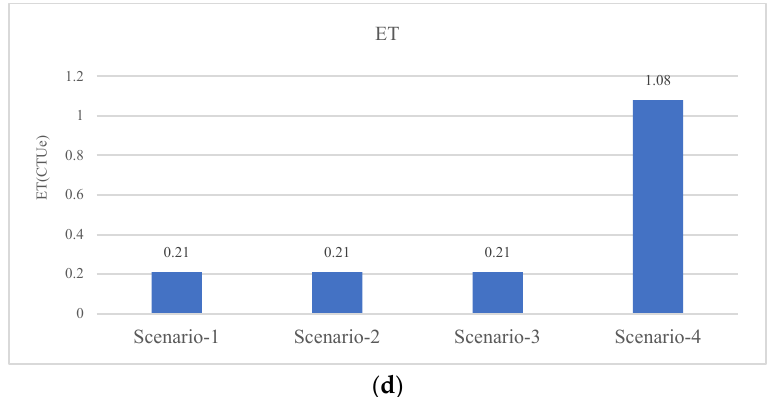
Figure 8. Results of impact assessment. ( a ) Results and comparison of global warming potential (GWP). ( b ) Results and comparison of primary energy demand (PED) and water utilization (WU). ( c ) Results and comparison of acidification effect (AP) and eutrophication effect (EP). ( d ) Results and comparison of ecological toxicity (ET).